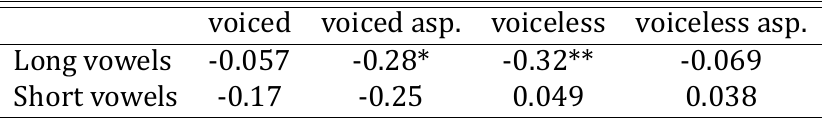
Table 6: Correlations between Hindi vowel duration and stop closure duration. N was approximately 61 in each group, with some variation due to errors and unreleased stops.